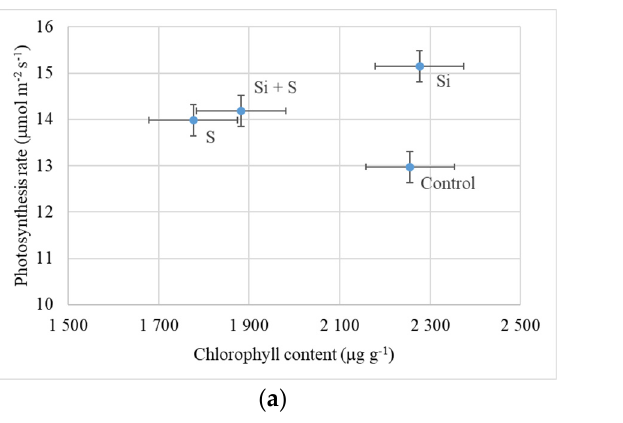
Figure 10. Chlorophyll a and b and carotenoid content spatial distribution maps generated in ArcGIS Pro from point sample laboratory measurements.